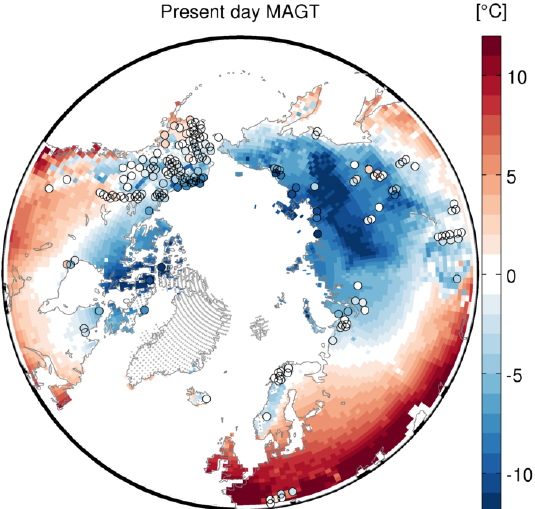
Figure 4. Scatter of modeled and observed present-day mean an- nual ground temperature (MAGT). Site level observations are from IPA (2010) and Romanovsky et al.